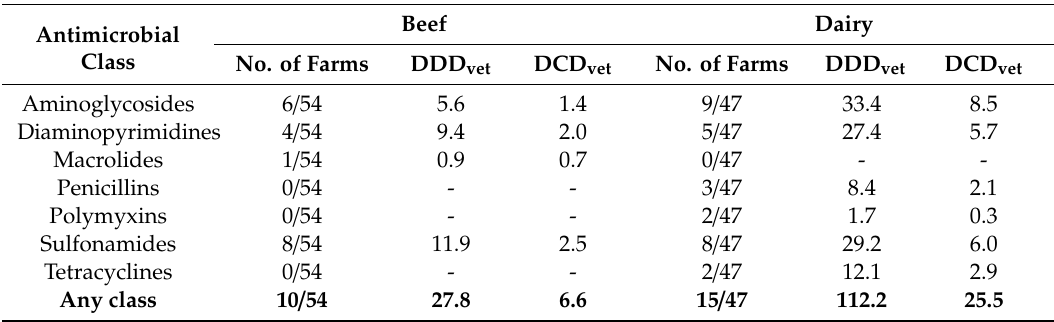
Table 2. Antimicrobial consumption (DDD vet / year × 10 − 3 − DCD vet / year × 10 − 3 ) via the oral route per antimicrobial class and breeding category (for each administration route classes are listed only if they were part of at least one treatment performed on either beef or dairy farms).